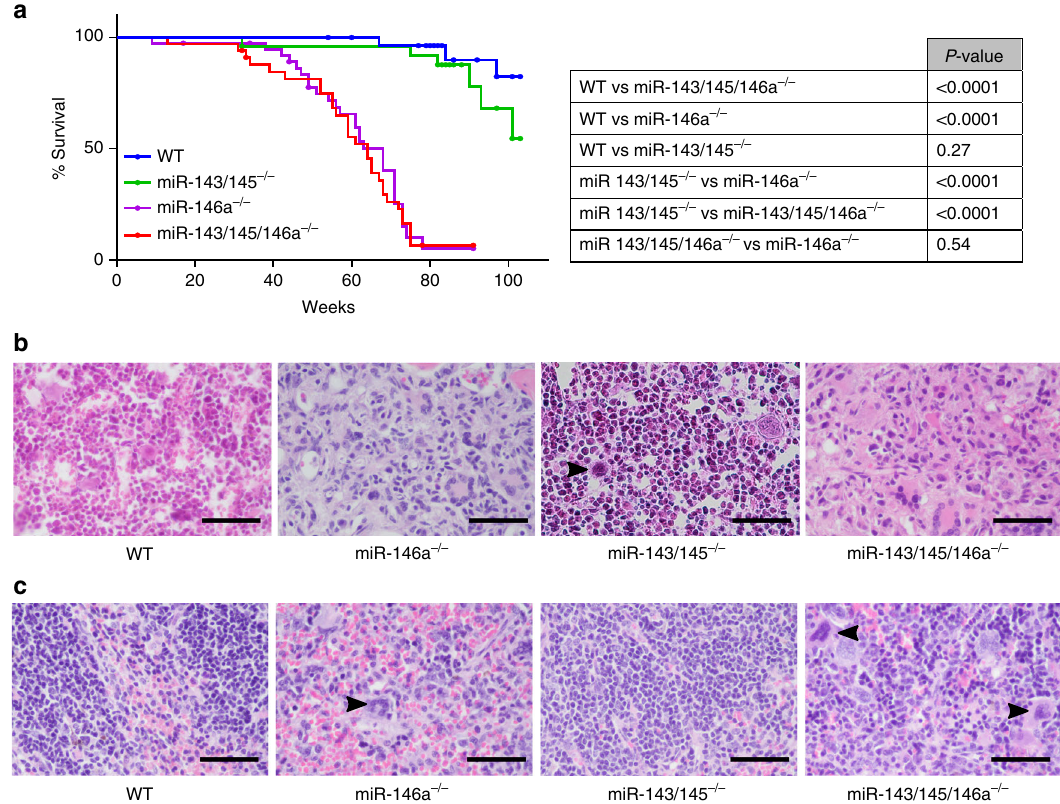
Fig. 6 Loss of miR-143 and miR-145 results in slight reduction in long-term survival. a Kaplan – Meier survival curve of wild-type (WT, n = 29), miR-143/145 − / − ( n = 20), miR-146a − / − ( n = 38), and miR-143/145/146a − / − ( n = 34) mice. Corresponding P values are indicated in the table. b , c Micrographs of H&E-stained marrow ( b ) and spleen ( c ) from WT, miR-146a − / − , miR-143/145 − / − , and miR-143/145/146a − / − mice (scale bar: 50 μ m). Hypolobated megakaryocytes (arrow) were distributed through the marrow of miR-143/145 − / − mice, while miR-146a − / − and miR-143/145/146a − / − marrows revealed extensive fi brosis. Extramedullary hematopoiesis was evident in miR-146a − / − and miR-143/145/146a − / − spleens (arrows indicate megakaryocytes), while miR-143/145 − / − mice showed normal splenic